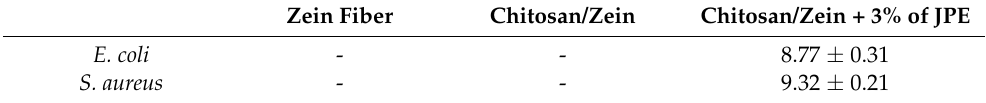
Table 5. The inhibition of halos (mm) against E. coli and S. aureus of the zein fiber and the bilayer